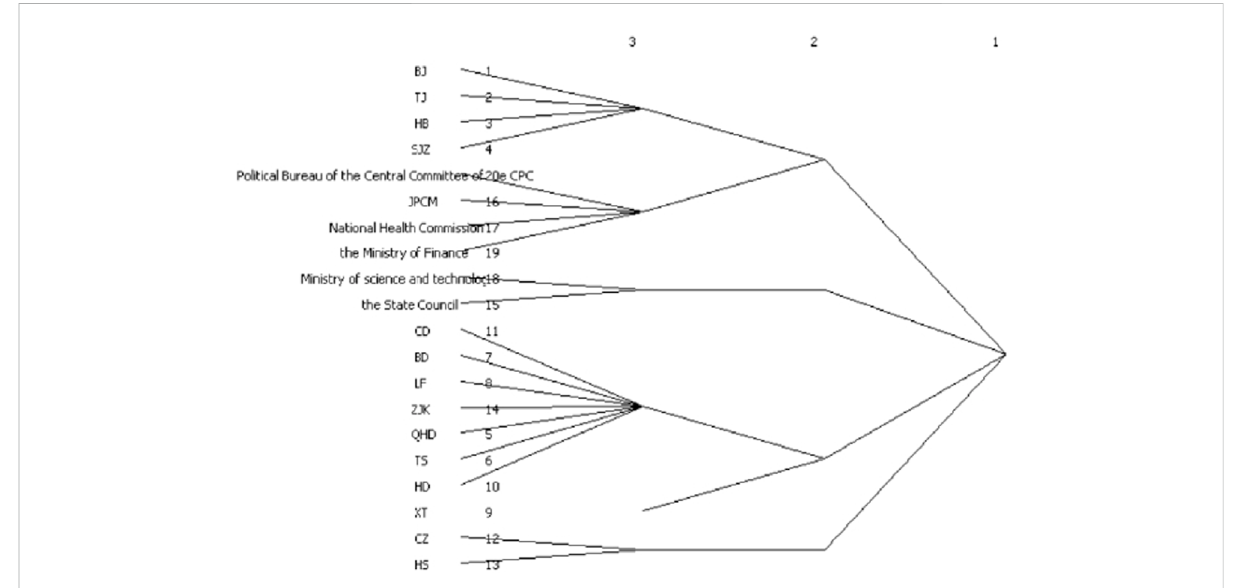
FIGURE 2 Clique analysis of the ECSNs for COVID-19 in the B-T-H